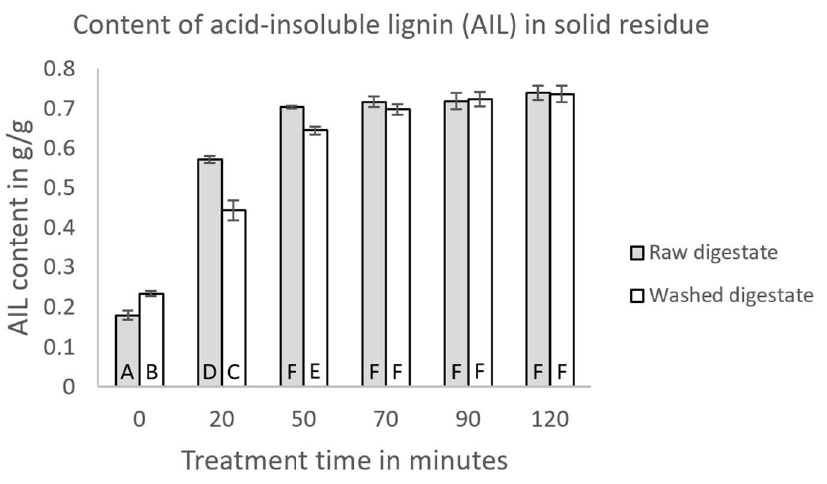
Figure A3. Content of acid-insoluble lignin (AIL) in solid residues remaining after hydrothermal and enzymatic treatment (as determined by compositional analysis, see Section 2.3.1). The letters A to F indicate whether the differences between the mean values are significant according to the Tukey–Kramer test at a significance level of α = 0.05. Results that share a letter are not significantly different from each other.